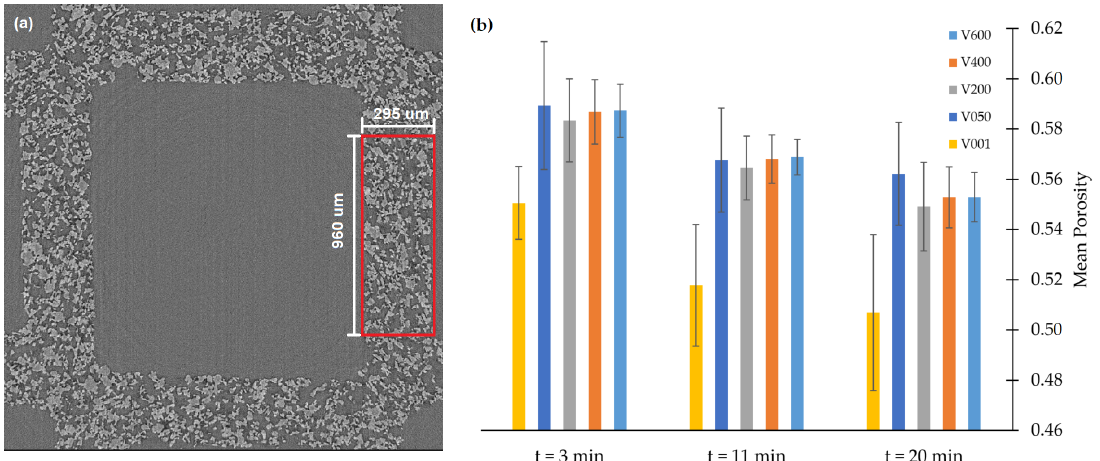
Figure 6. ( a ) A virtual micro-CT slice showing a cross section of a volume used for REV determination. ( b ) Plot of the mean porosity and error ( ± 1SD) for five different sub-volume lengths (V600, V400, V200, V050 and V001) at three different loadings (t = 3 min, t = 11 min, t = 20